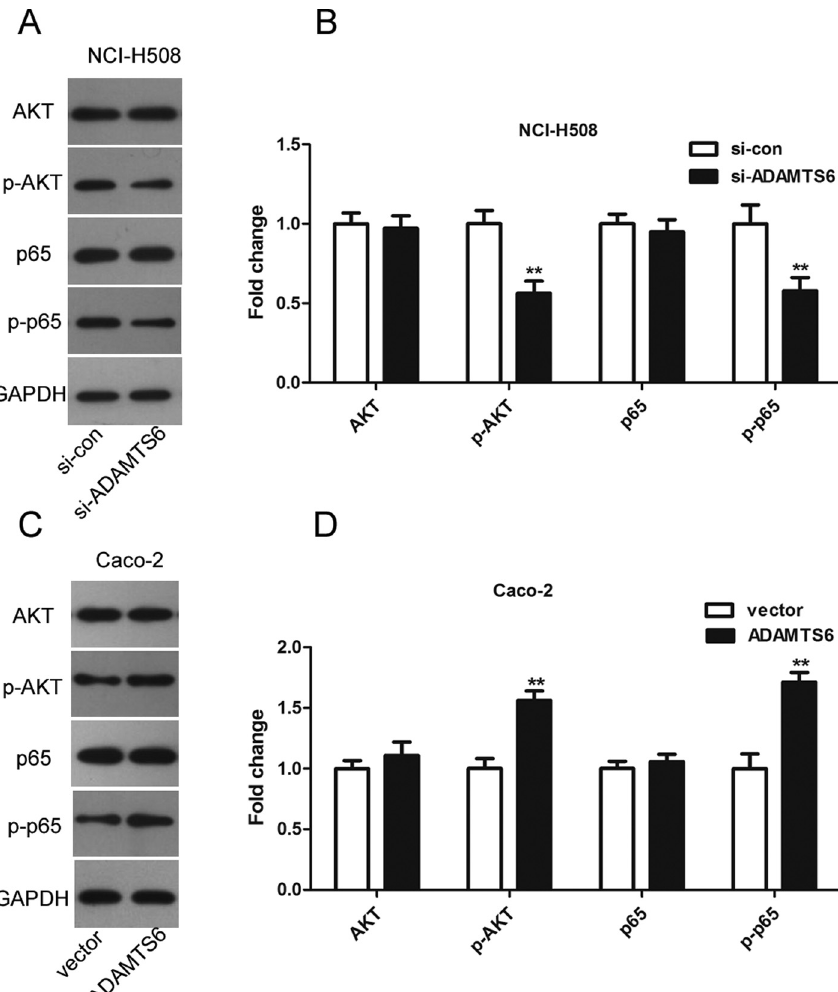
Figure7 -TheeffectofADAMTS6ontheactivationofAKTandNF- (cid:2) Bincoloncancercellswasdetectedbywesternblotting.(AandB)Theexpression of AKT, p-AKT, p65 and p-p65 in NCI-H508 cells. ** P <0.01 vs. si-control group. (C and D) The expression of AKT, p-AKT, p65 and p-p65 in Caco-2 cells. ** P <0.01 vs. vector